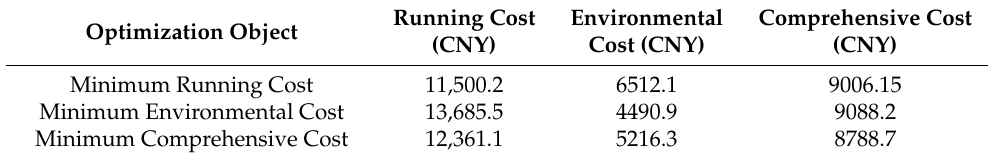
Table 12. Comparison of optimization results of different schemes for a typical day in summer. Running Optimization Object